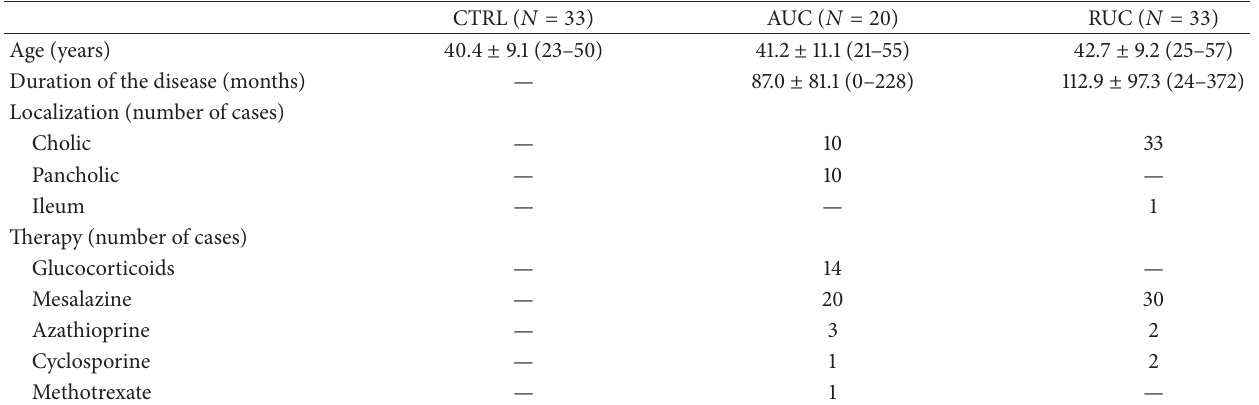
Table 1: Clinical features of the study cohort.